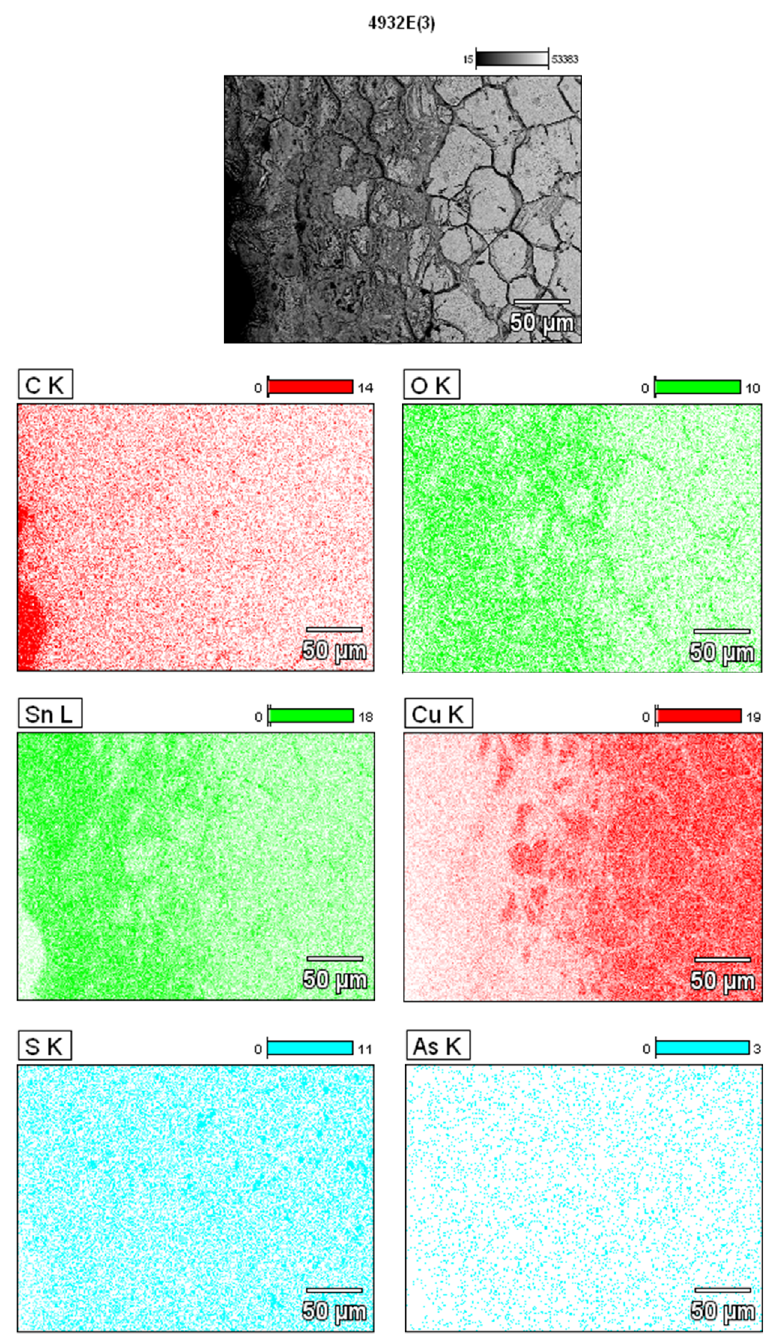
Figure 2. Elemental map of the alloy components from the sample of the neck collar from Raven, Kr. Harburg, Lower Saxony (LMN 4932). The sample is taken of the end plate of the collar (scan: Dirk Kirchner, German Mining Museum, Bochum). and the tin proportion falls below its original value (figure 6 and 7). Additionally, sulphur content reaches its peak at the transition to the coating. This phenomenon becomes apparent in mapping the distribution of these elements. Both the distribution of copper (Cu) and tin (Sn) within the sample indicate a coating, as does the linear concentration of sulphur (S) along the surface of the artefact (figure 8). The appearance of tin, arsenic, and iron in the coating layer prompts one to question what this coating was made of and how it may have come to be present on the surface of such